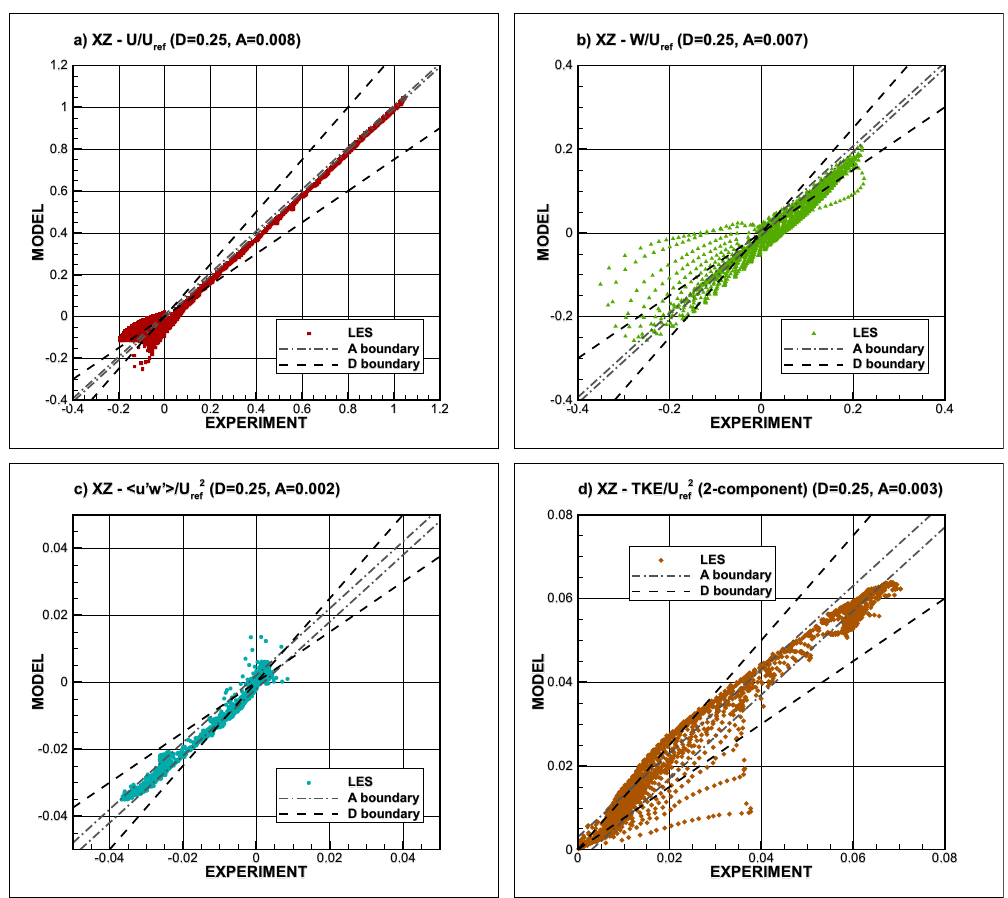
Figure 4. The Scatter plots of the measured (PIVa) and simulated (LESa) values obtained within the street canyon for the dimensionless ( a ) streamwise velocity; ( b ) vertical velocity; ( c ) momentum flux and ( d ) turbulent kinetic energy. Dashed lines denote the relative deviation D ; dashed-and-dotted lines denote the absolute deviation A . 2400 points are plotted for each